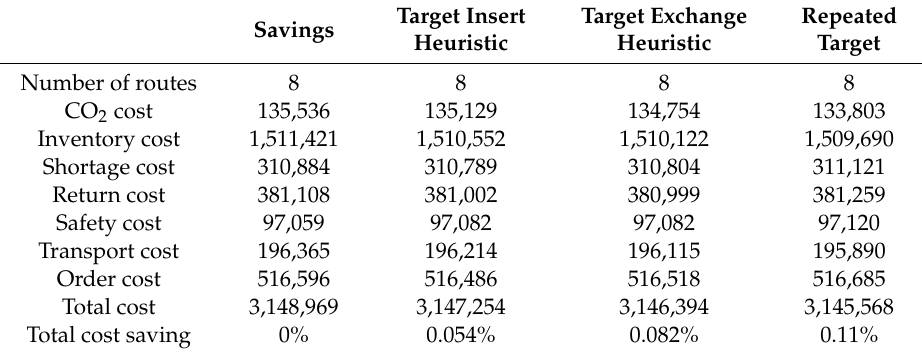
Table 8. The simulated numerical results for ROPIRPSDRCO 2